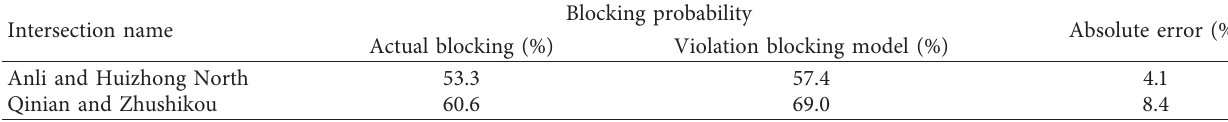
Table 2: Running red light at the through phase: model